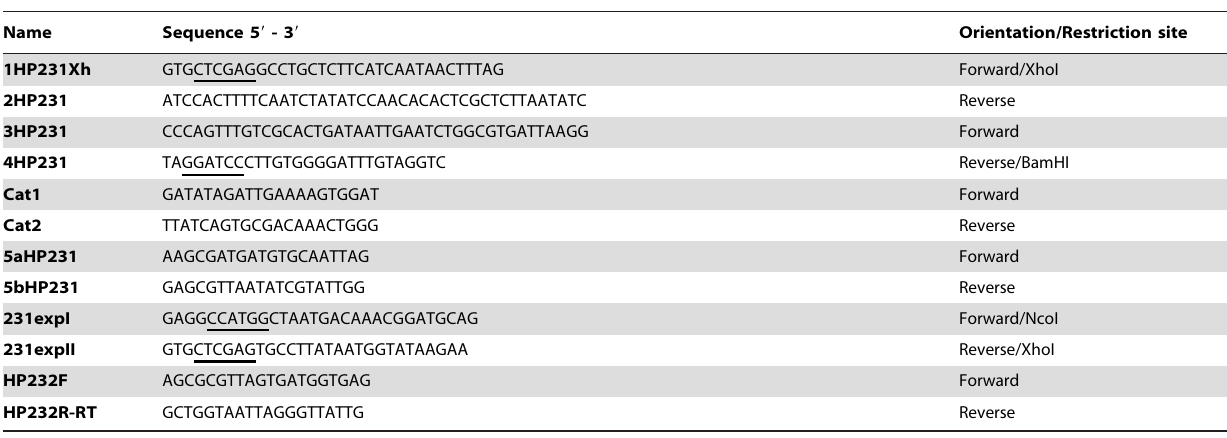
Table 2. Primers used in this